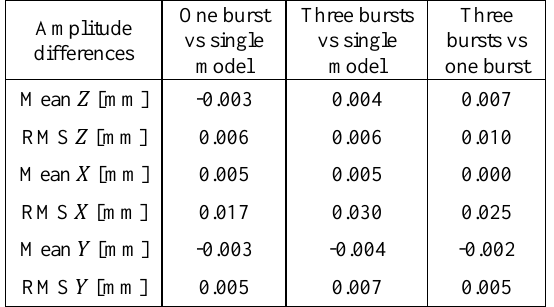
Table 7. Bias and RMSE of the estimated amplitude values between the different adjustments (1 Hz)